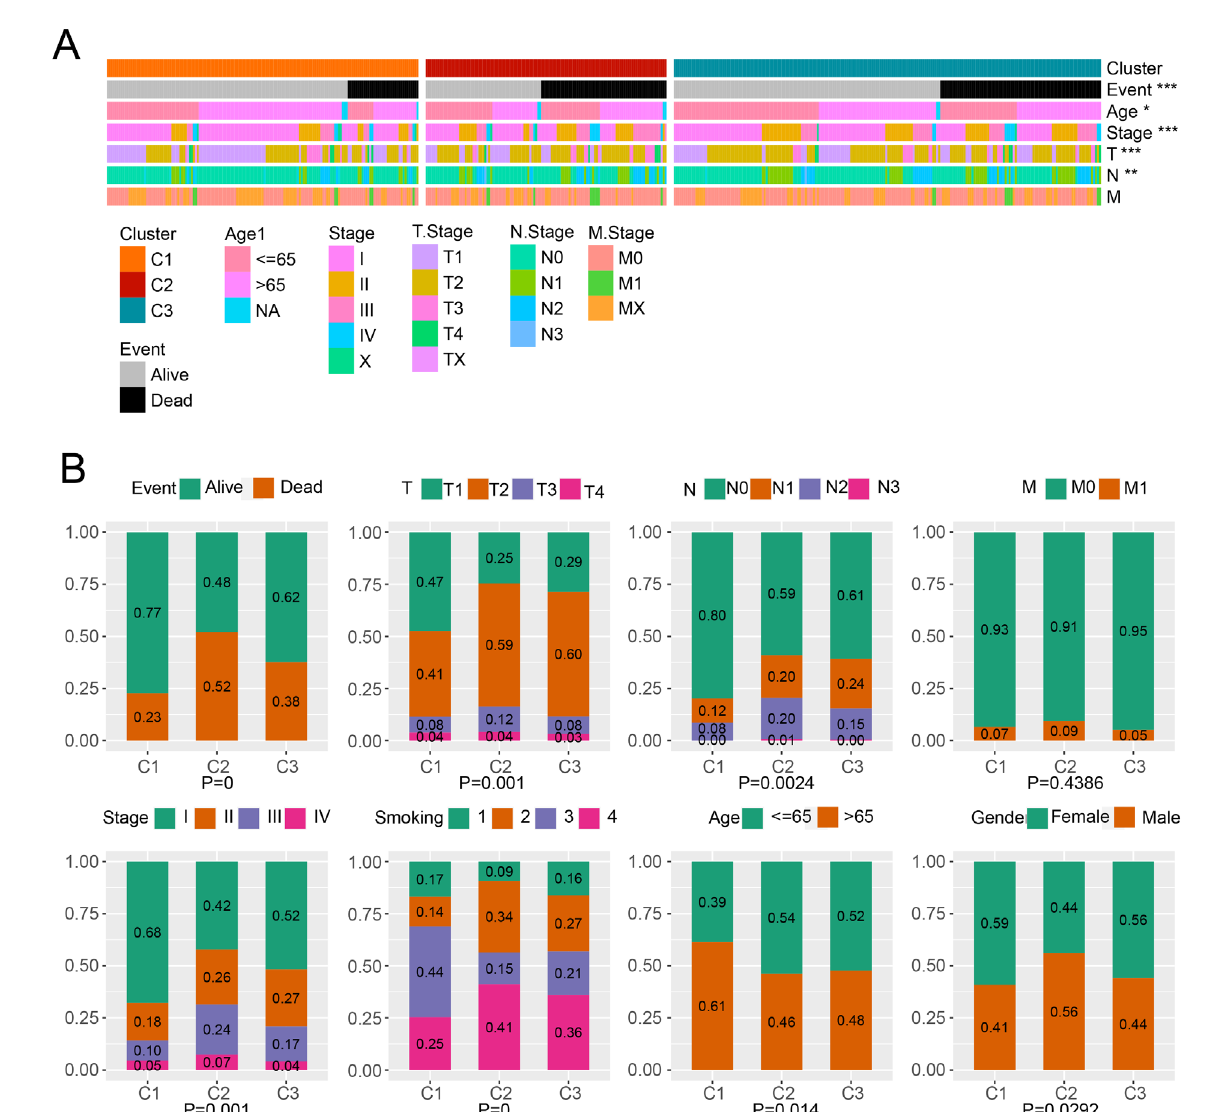
Figure 2 – Association of clinical characteristics with the 3 clusters. (A) A cluster map showing association the of 3 clusters with clinical characteristics. (B) Comparison of distribution of clinical characteristics of different molecular subtypes. * p < 0.05, ** p < 0.01, *** p < 0.001, **** p <